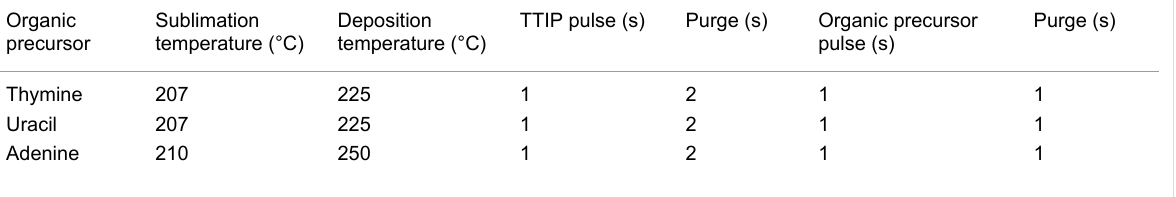
Table 1: Deposition conditions for QCM investigation and obtained pulse and purge parameters. Organic precursor